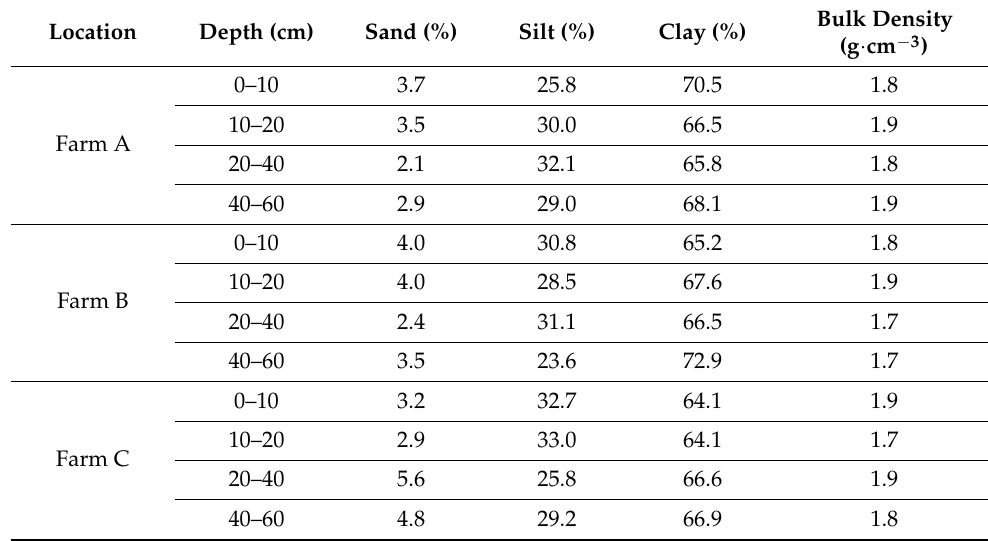
Table 1. Summary of soil texture and density at the three investigated